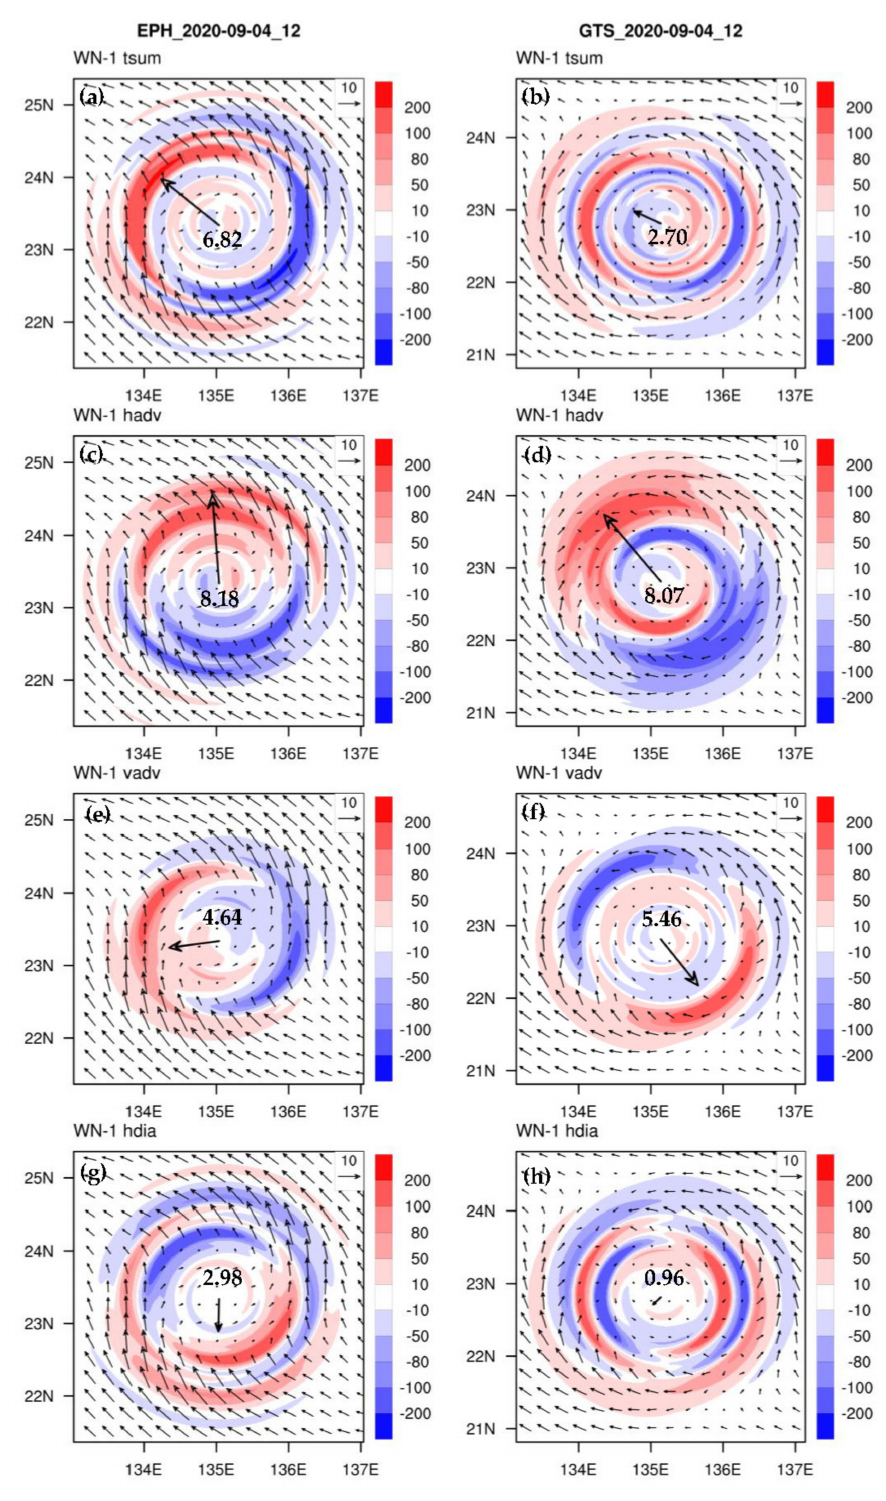
Figure 10. The horizontal wind and wavenumber-1 (WN-1) PV tendency budget (shaded colors, 10 − 5 PVU s − 1 ) averaged in 1–8 km height at 1200 UTC 4 September 2020 for EPH for ( a ) net PV budget, ( c ) horizontal PV advection, ( e ) vertical PV advection, and ( g ) differential diabatic heating. ( b , d , f , h ) as in ( a , c , e , g ), respectively, but for GTS. The bold reference wind vector (in m s − 1 ) at the vortex center indicates the induced net translation velocity, and a reference wind vector (m s − 1 ) is given in the upper right of each panel for the wind